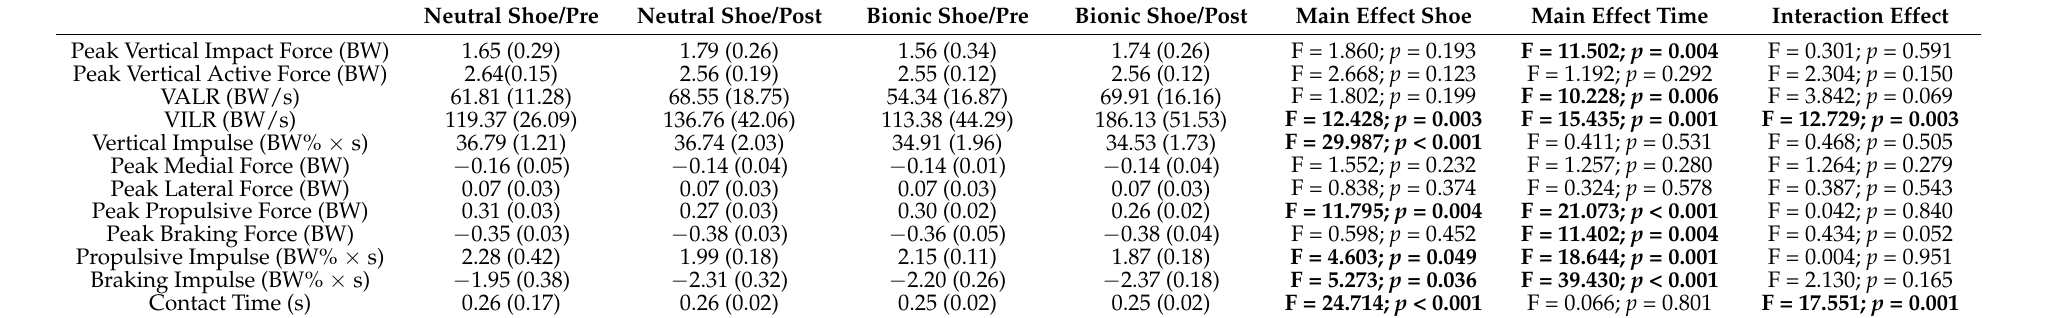
Table 2. Mean (SD) of ground reaction forces (GRFs) characteristics for the four experimental